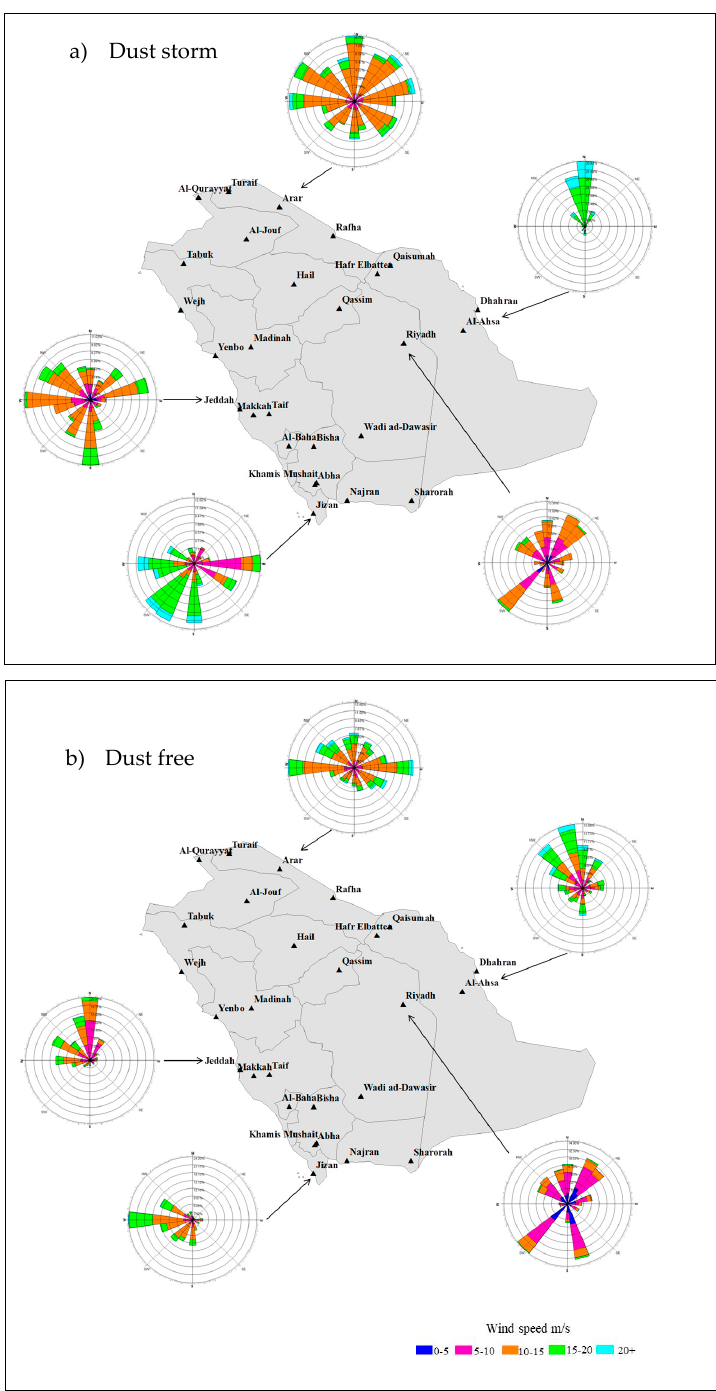
Figure 10. Wind roses representing wind direction and wind speed covering the period 2005–2017 under dust storm conditions ( a ) and dust-free conditions ( b ).